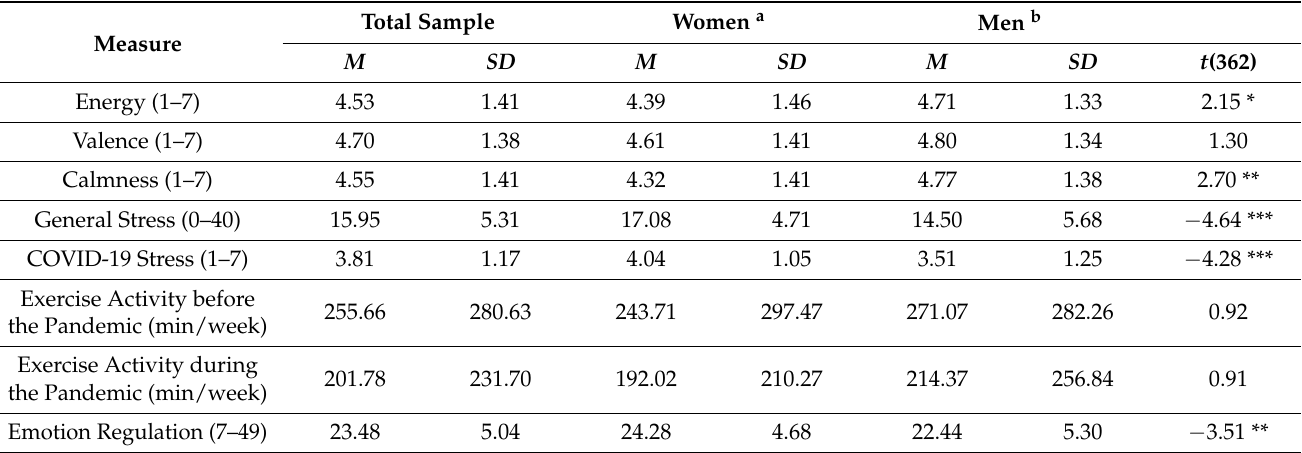
Table 2. Descriptive statistics and gender differences in study variables.